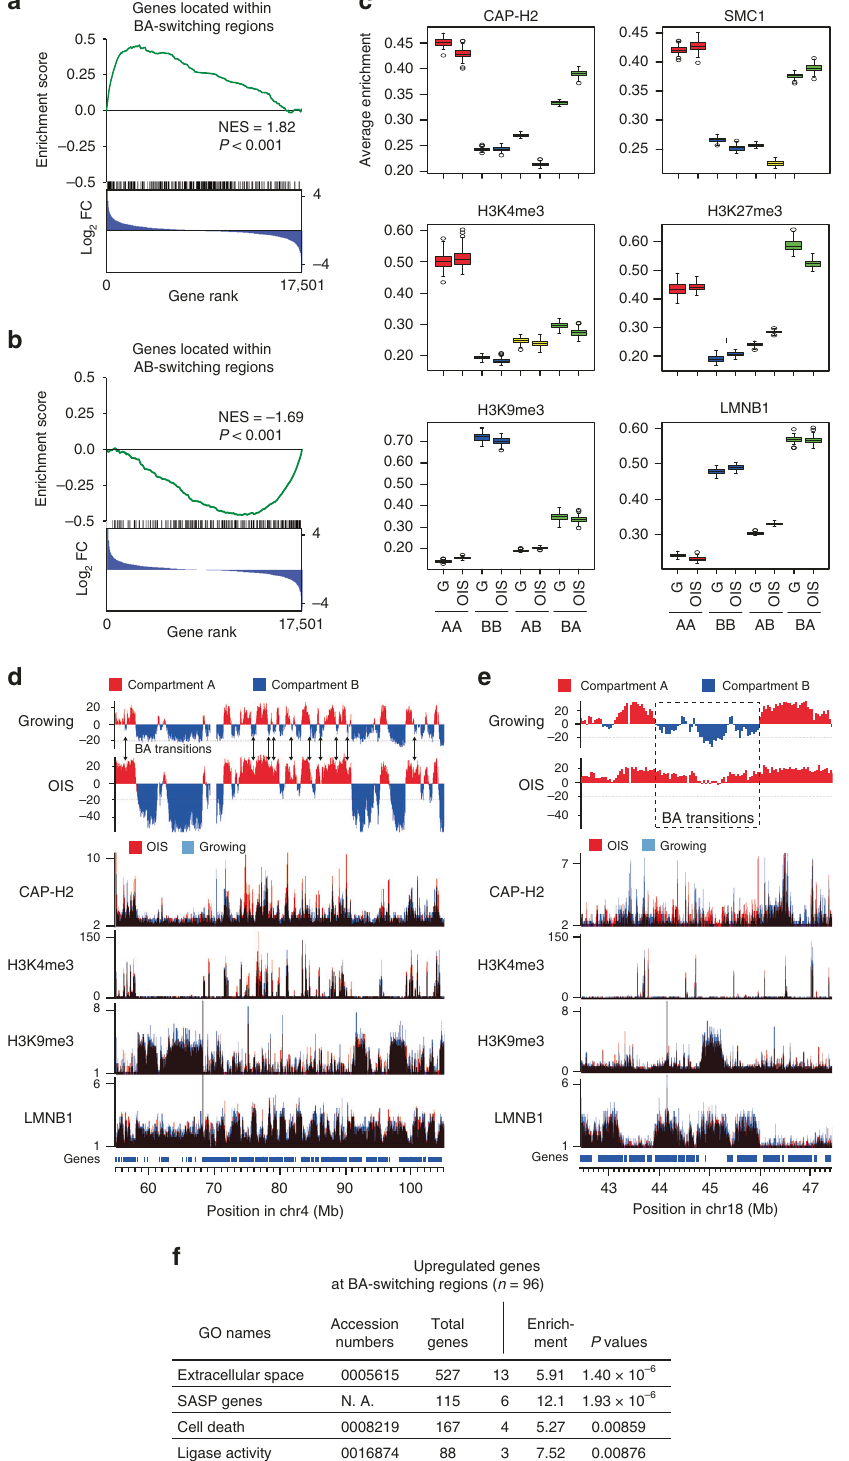
(Supplementary Fig. 6a). DAPI foci were detected in about 20% of IMR90 RS cells but not in BJ RS cells (Supplementary Fig. 6b). expression 48,49 .